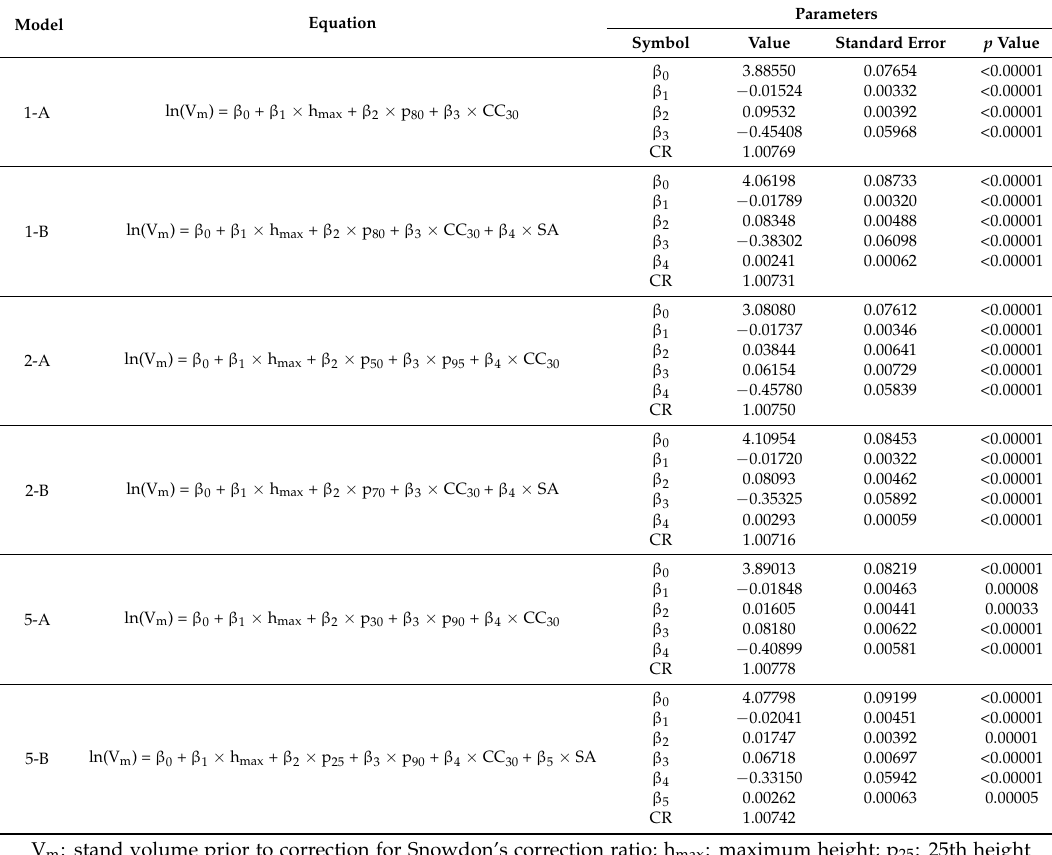
Table A2. Description (selected independent variables, estimated parameters, standard errors and significance values) of six selected stand-level volume models, including Snowdon’s correction ratio (CR) for bias correction (Equations (2) and (3)). Two models were selected for each CHM resolution which the model was developed, whereas letter denotes whether the model was derived solely from CHM metrics as independent variables (A), or from both CHM metrics and FMP variables